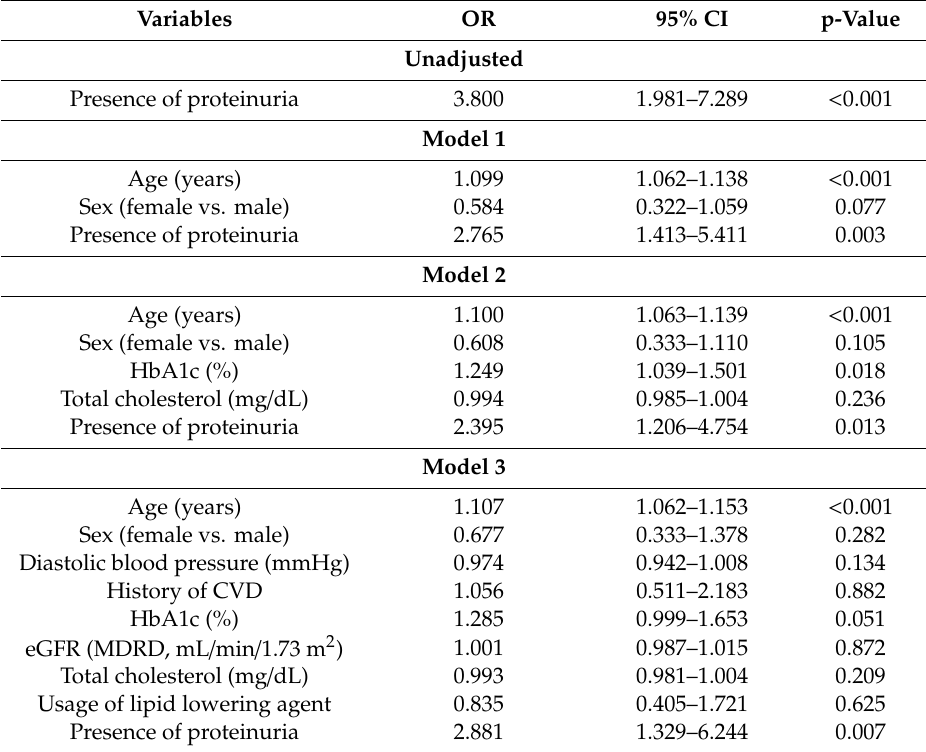
Table 3. Odds ratios for significantly increased CIMT by proteinuria.